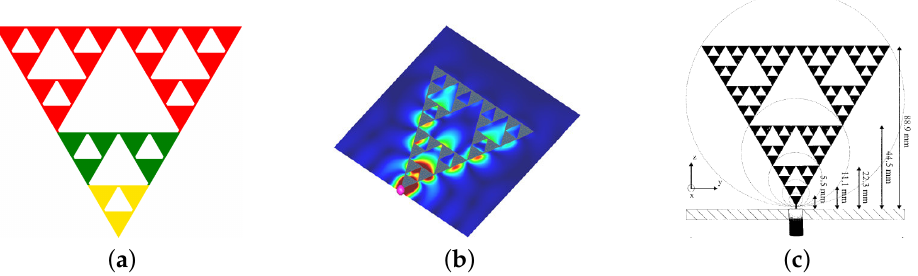
Figure 15. Resemblance of Sierpinski gasket antenna to bow-tie antenna. ( a ) Three stages of Sier- pinski antenna, ( b ) Fabricated Sierpinski antenna, ( c ) Length scales of Sierpinski antenna. (Im- age source: https://www.emcos.com/wp-content/uploads/2014/01/Application_Note_Fractal_ Antennas_Simulation_Sierpinski_Gasket.pdf, accessed on 22 June